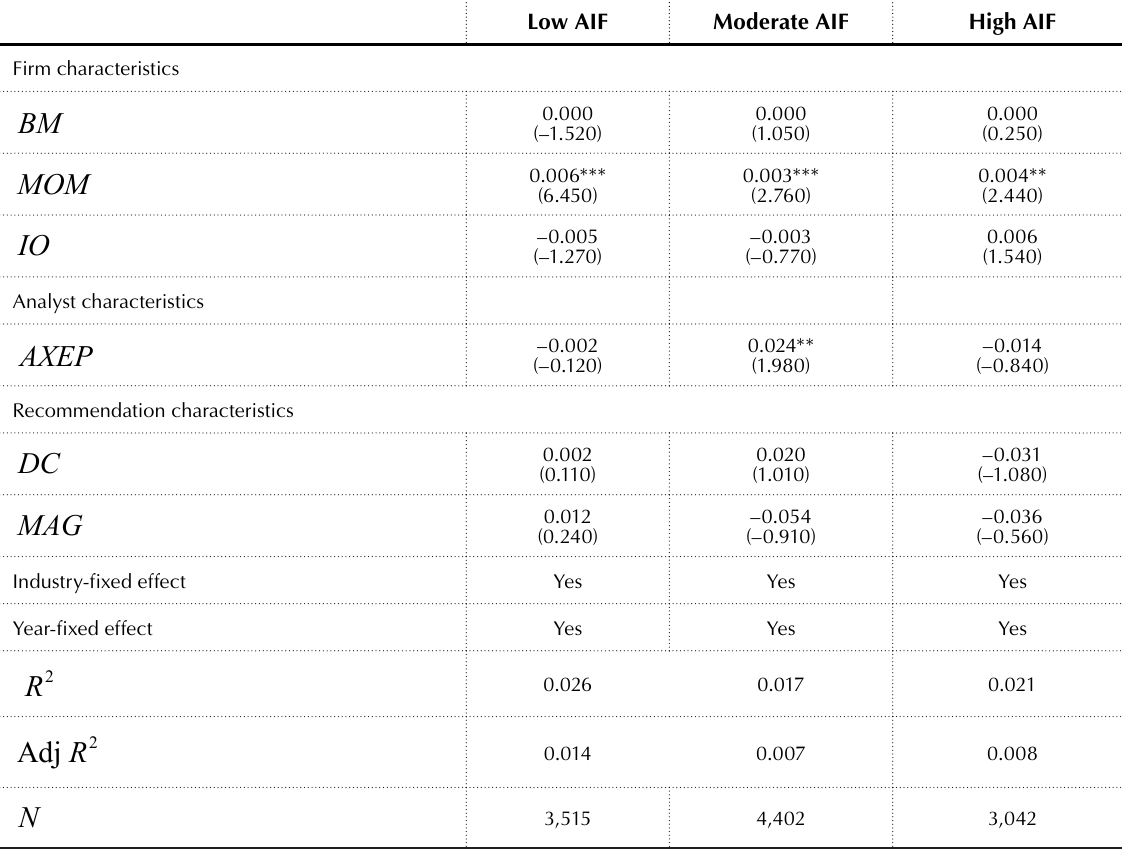
Table 6 (cont). The effects of ambiguity in information and market ambiguity on BHARs under different levels of ambiguity in